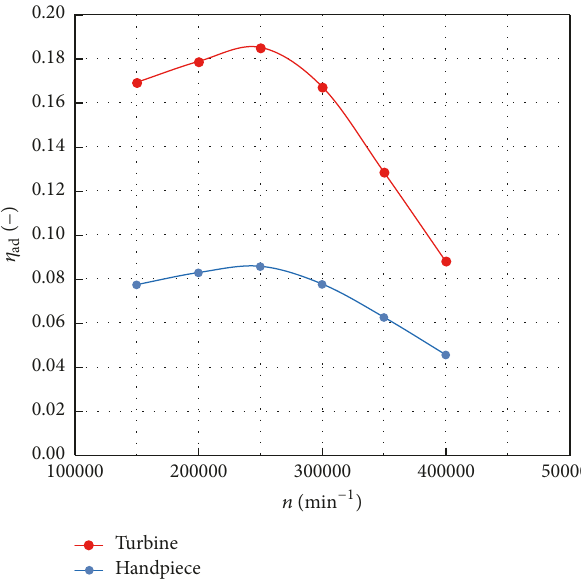
Figure 13: Correlation between rotational speed and adiabatic efficiency.